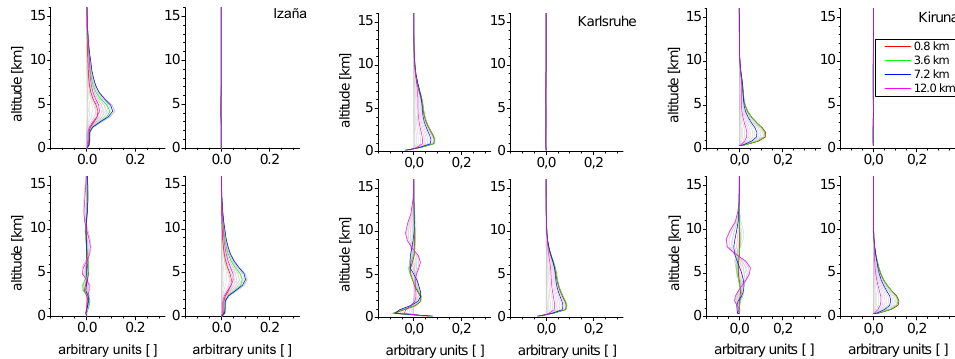
8 Wiegele et al.: The MUSICA MetOp/IASI H 2 O and δ D products Figure 4. Same as Fig. 2 but for the a posteriori corrected {humidity, δ D} proxy state (kernel matrix A 00 according to Eq. 7). Fig. 4. Same as Fig. 2 but for the aposteriori corrected { humidity, δ D } -proxy state (kernel matrix A 00 according to Eq. 7).